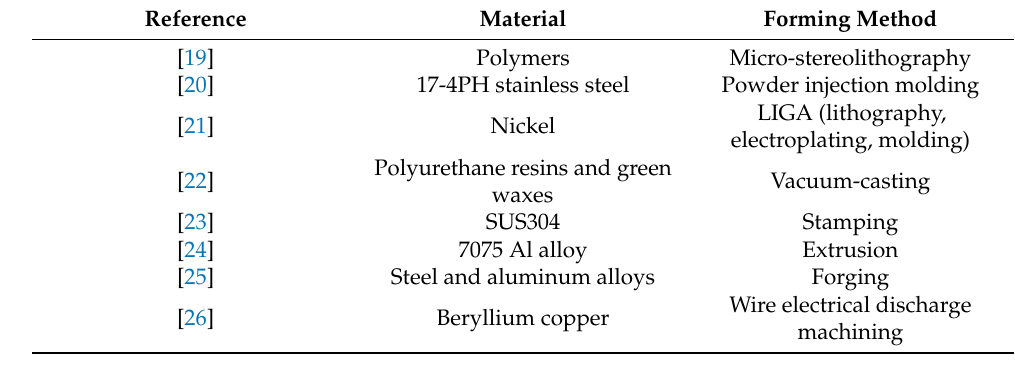
Table 1. Manufacturing methods of